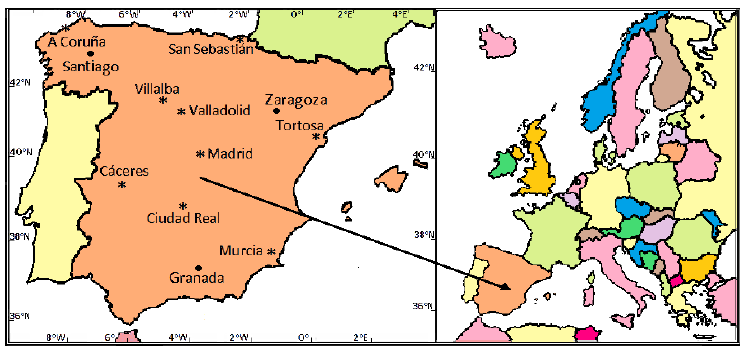
Figure 1. Spatial distribution of the selected measuring stations in Spain. (•) rural stations.